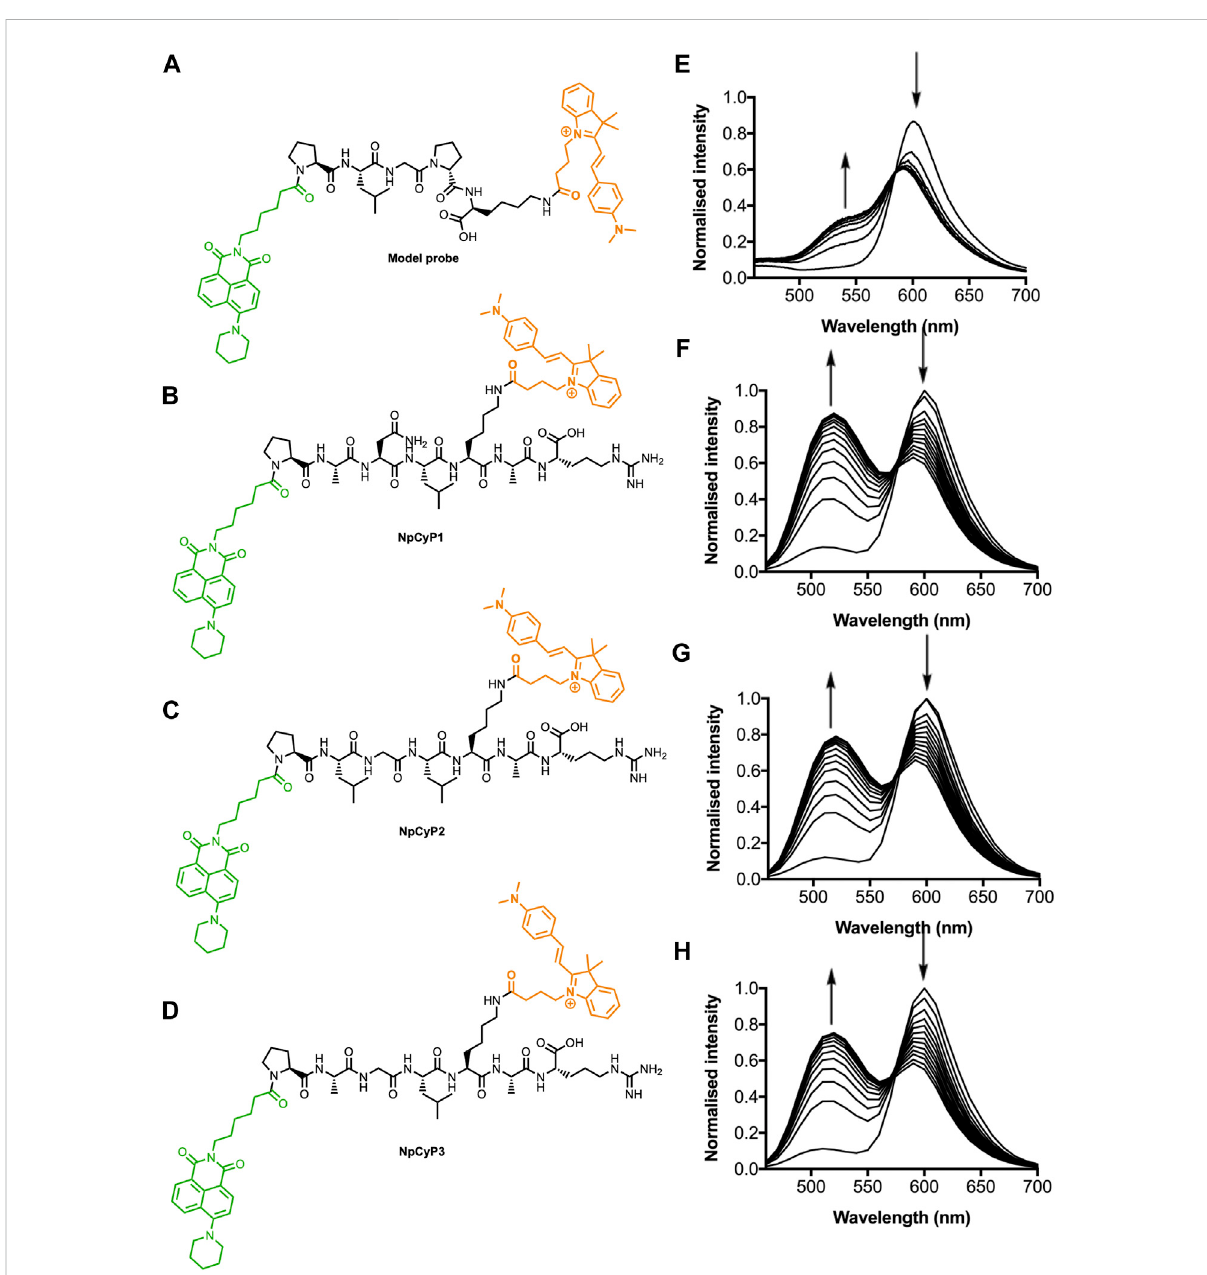
FIGURE 1 Structureandnormalised fl uorescencespectraofprobesduringdigestionwithproteases.StructuresoftheNpCyC (A) ,NpCyP1 (B) ,NpCyP2 (C) , and NpCyP3 (D) . Normalised fl uorescence emission spectra of NpCyC during digestion with typeIV collagenase (E) . The reaction mixture contained probe(50 μ M)andtypeIVcollagenase(3.3 μ g/ml)inKrebs-Ringerbuffer(pH7.4)andwasmonitoredat25 ° Ctaking1scanevery2 minusing405 nm excitation. Normalised fl uorescence emission spectra of NpCyP1 (F) , NpCyP2 (G) , and NpCyP3 (H) in patient-derived synovial fl uid presenting with in fl ammatory arthritis. Spectra represent changes to fl uorescence in 10 min intervals over 2 h. Arrows indicate changes with increasing incubation